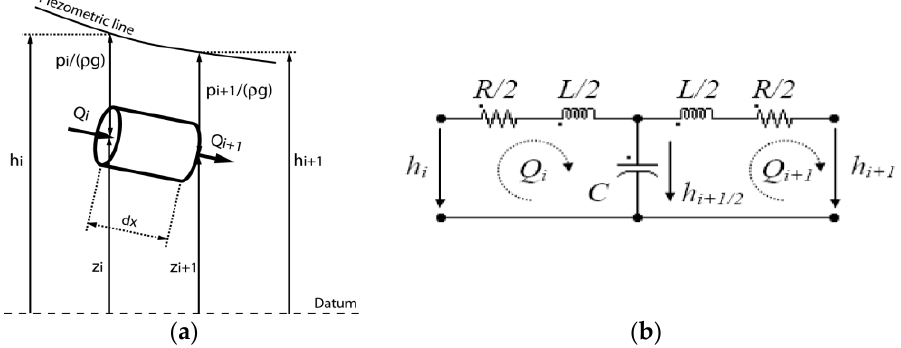
Figure 5. Pipe model , ( a ) Model of a section of pipe, and ( b ) the equivalent scheme.